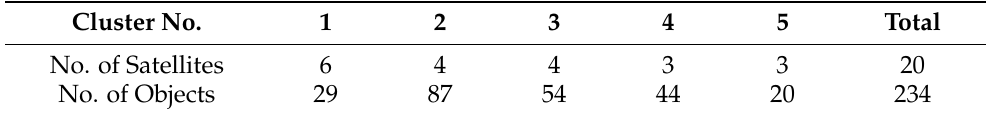
Table 6. Number of objects allocated to each satellite cluster. There were 34 objects allocated to multiple satellites. The total number of objects is 200.